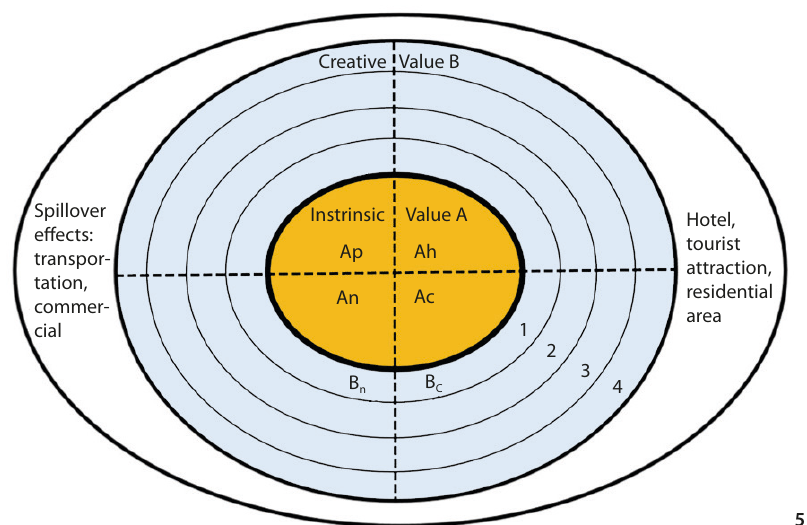
Figure 5 Framework of the value of industrial 5 heritage (Source: